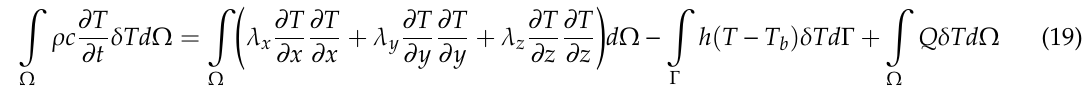
Figure 12. Asymmetric minimum element thermal (TH) field.